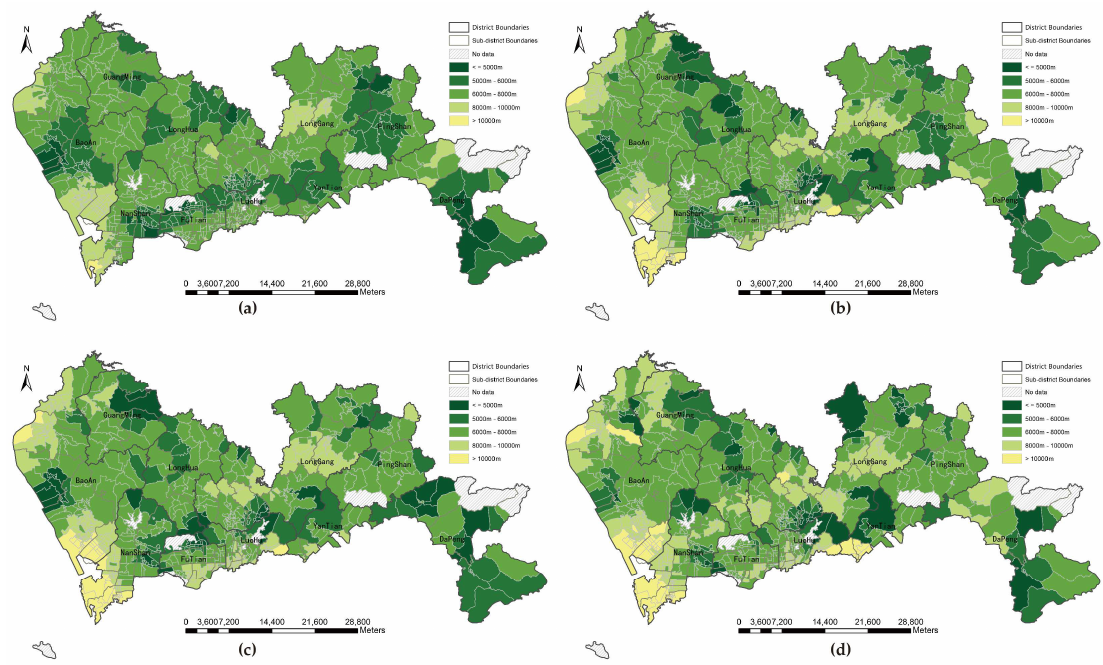
Figure 5. Proximity to natural parks in threshold of 10 km by four types of distance: ( a ) Euclidean distance; ( b ) walking distance; ( c ) bicycling distance; ( d ) driving